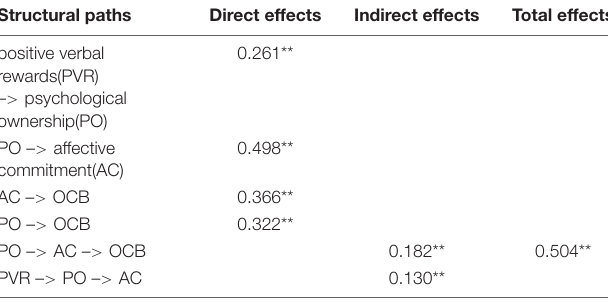
TABLE 6 | Direct and indirect effects of the